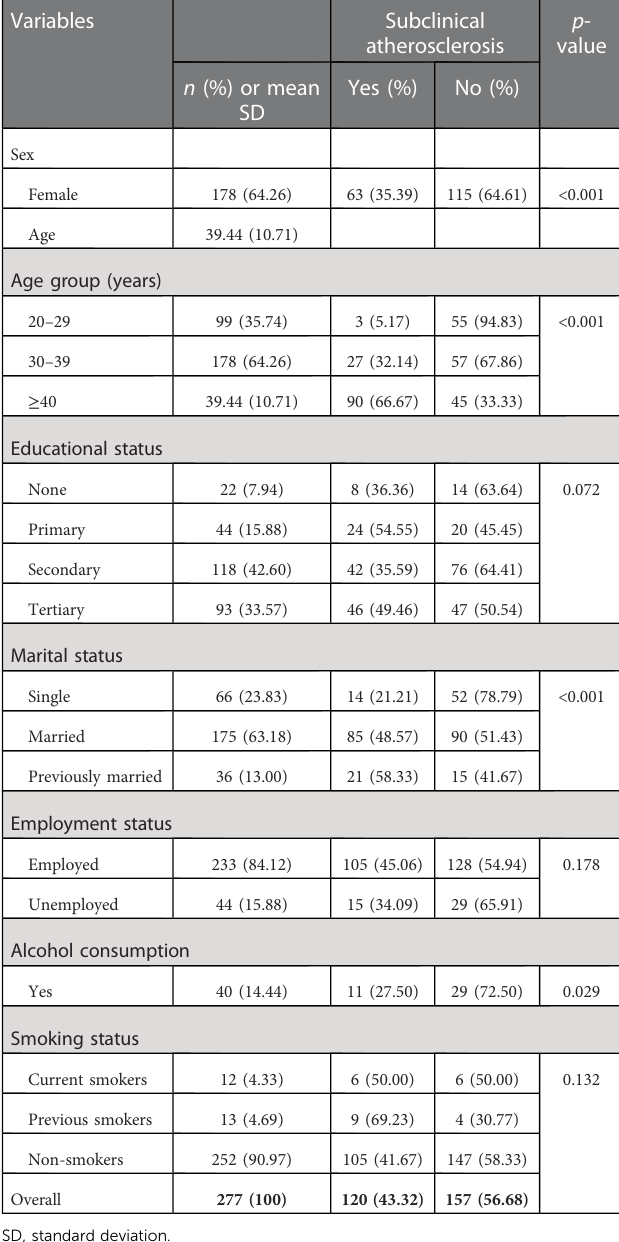
TABLE 1 Socio-demographic characteristics, habits and associations with subclinical atherosclerosis.